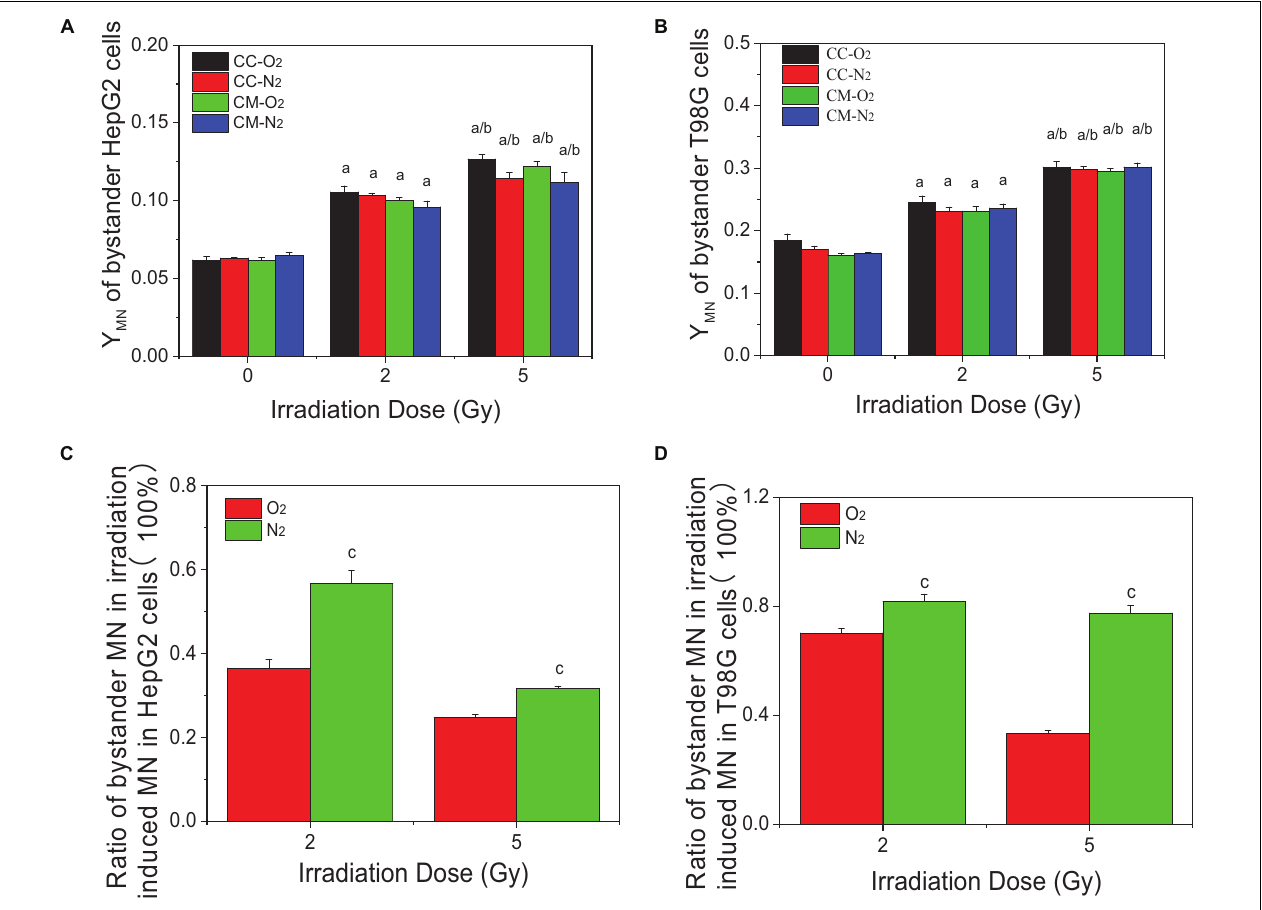
FIGURE 2 | Micronucleus induction in non-irradiated bystander cells of HepG2 and T98G under hypoxic and normoxic conditions. The bystander cells were either co-cultured with irradiated conspecific cells (CC-O 2 and CC-N 2 ) or treated with the conditioned medium (CM-O 2 and CM-N 2 ) harvested from irradiated conspecific cells under the same oxygen conditions. The ratio of bystander micronucleus (A,B) to radiation-induced micronucleus of HepG2 cells (C) and T98G cells (D) under hypoxic and normoxic conditions was plotted. a, p < 0.05 compared with the 0-Gy group; b, p < 0.05 compared with the 2-Gy group; c, p < 0.05 compared with the normoxic